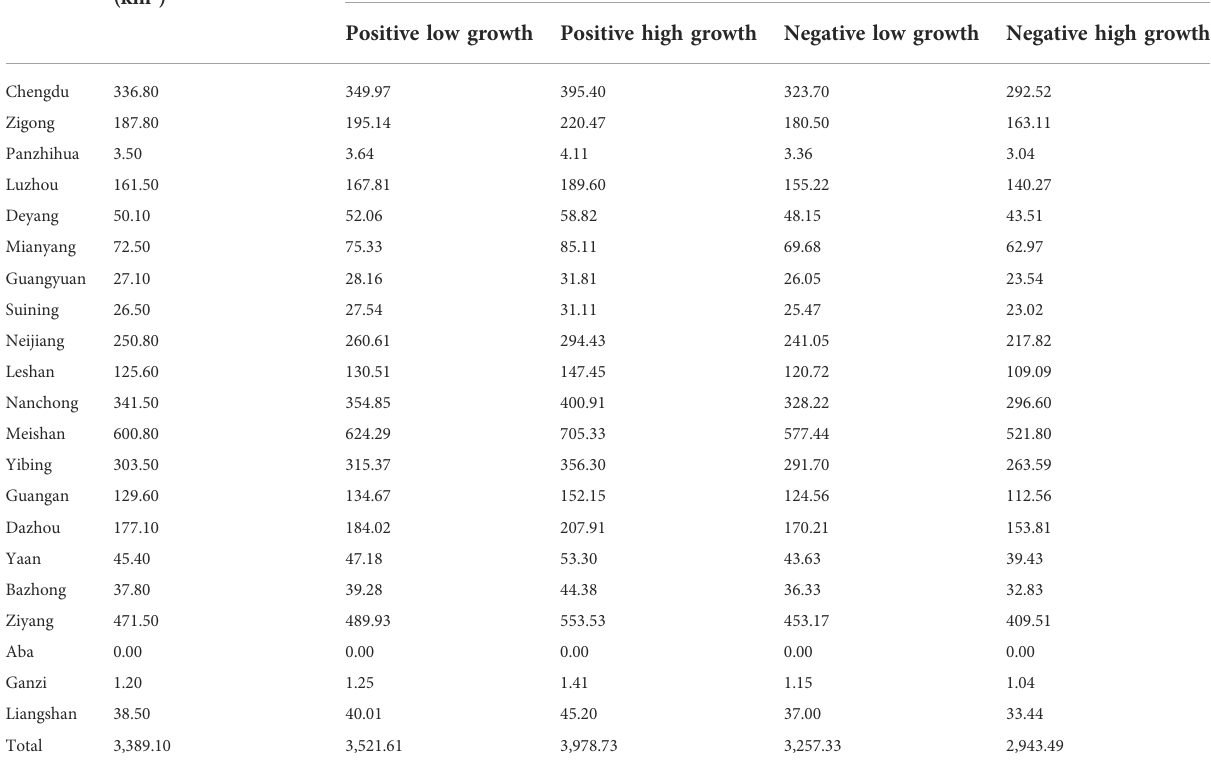
TABLE 4 Predicted area of Citrus in Sichuan Province under different scene in